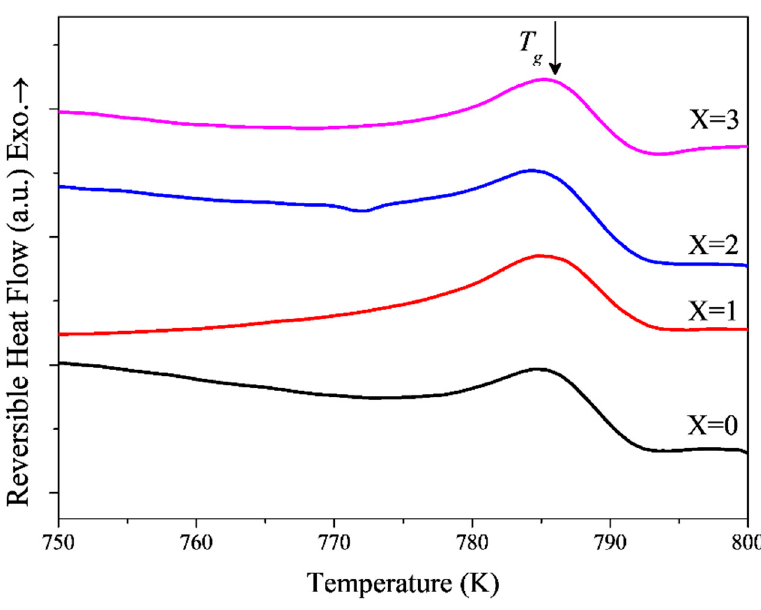
Figure 2. DSC curves of the as-spun Fe 76 Si 9 − x B 10 P 5 Mo x ( x = 0, 1, 2 and 3) ribbons with a heating rate of 20 K/min.